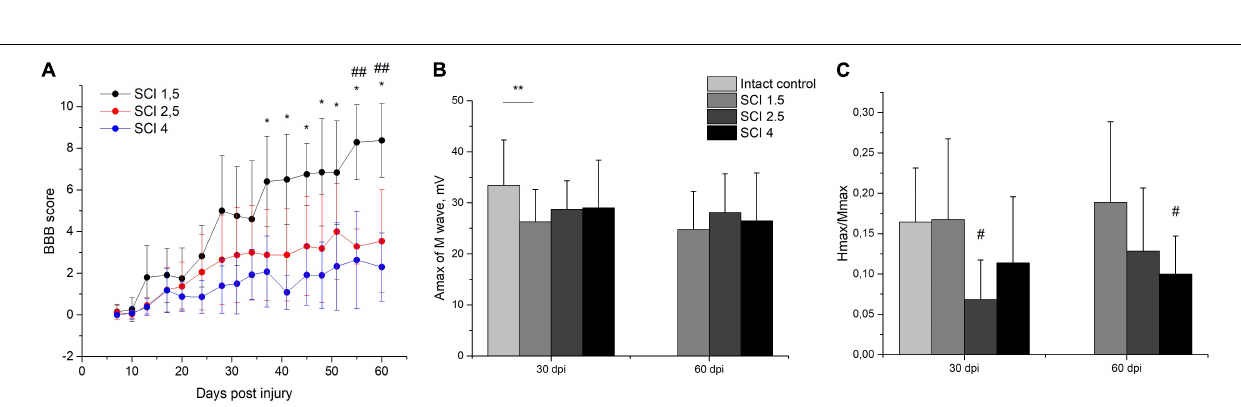
FIGURE 1 | Tissue analysis in experimental groups. An area of the spared tissue (A) and a total area of abnormal cavities (B) 5 mm rostrally and caudally from the injury epicenter on Day 60 after spinal cord injury of mild (SCI 1.5, n = 8), moderate (SCI 2.5, n = 8), and severe (SCI 4, n = 8) severities. No significant differences in the above indicators of morphometric analysis were found between the experimental groups, one-way ANOVA followed by a Tukey’s post hoc test. (C) Cross sections of the injured spinal cord on Day 60 after spinal cord injury in experimental groups with azur-eosin staining.